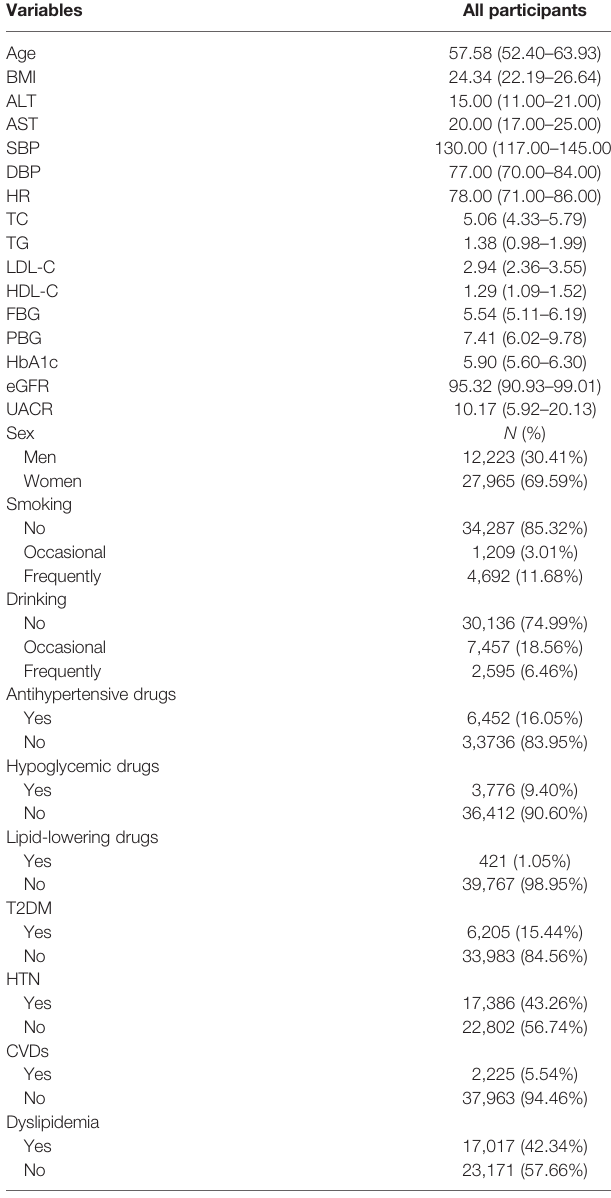
TABLE 1 | Characteristics of total